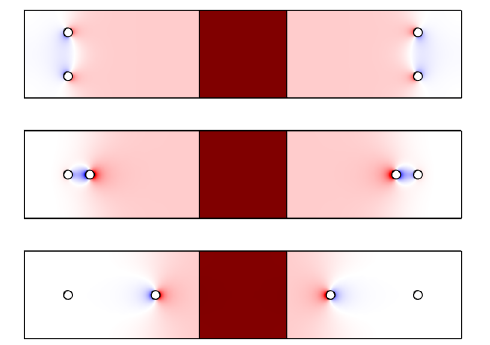
Fig.3: Volume impedance density field plots for the three models, starting with model A at the top followed by model B and C. The red regions represent positive volume impedance density while the blue regions represent negative volume impedance density. The absolute value is higher the stronger the color is.